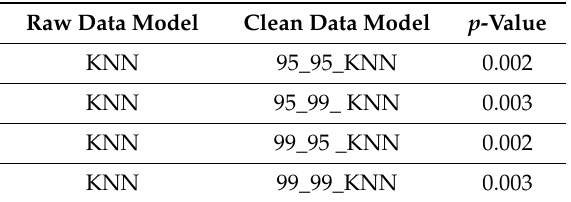
Table 18. p -value for t -test comparison for the KNN (raw data model) against KNN (cleaned data models) when tested against raw